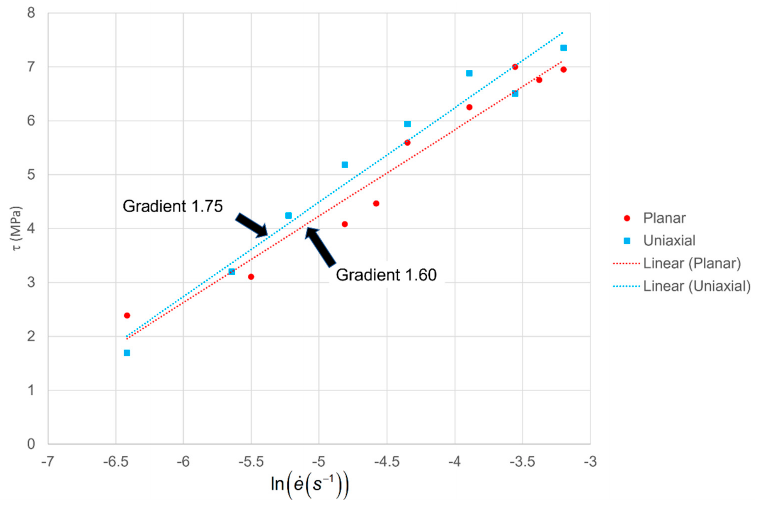
Figure 6. Plots of octahedral shear stress at yield against logarithm of octahedral shear strain rate for planar and uniaxial stretching.